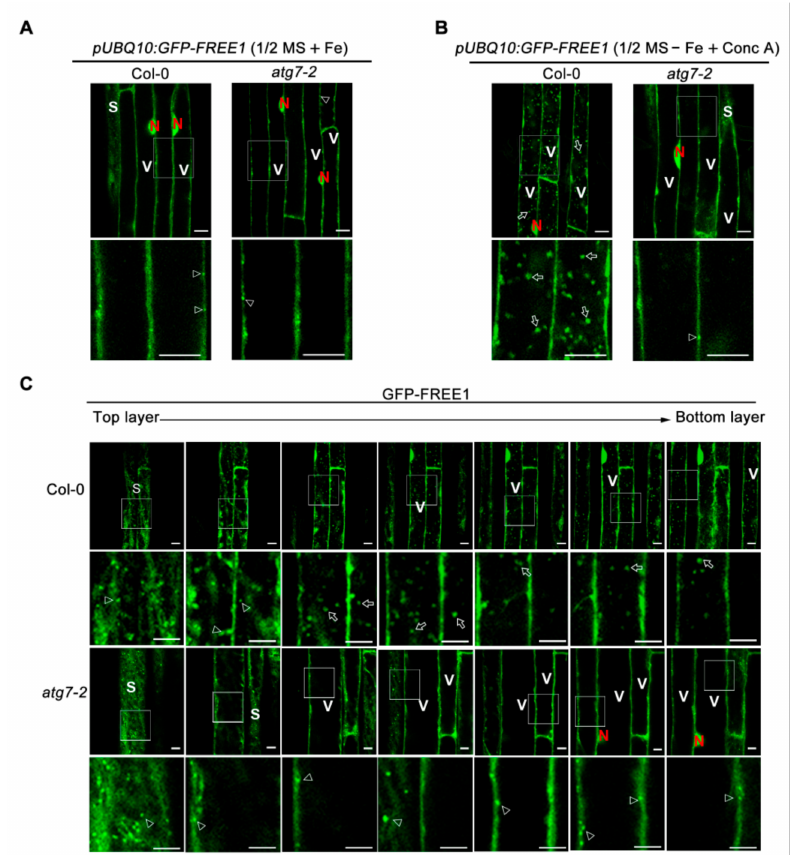
Figure 4. Autophagy-dependent FREE1 entry into the vacuole in response to iron-deficiency. ( A ) and ( B ) 6-d-old Arabidopsis seedlings expressing proUBQ10:GFP-FREE1 in Col-0 and atg7-2 background grown on 1/2 MS + Fe medium plates ( A ) were transferred to 1/2 MS-Fe liquid medium for 12 h followed by another 8 h treatment in 1/2 MS − Fe liquid medium containing 0.5 µ M Conc A before confocal observation of the root elongation zone. The untreated plants were used as a control. The punctate MVB localization of GFP-FREE1 was easily observed in the surface layer (the thin cytoplasm region) of the root cells in the elongated zone. The number of GFP-FREE1 puncta inside vacuole was obviously decreased in atg7-2 mutant comparing with that in WT plant cells. Bars = 10 µ m. ( C ) Serial confocal optical section of those plants shown in ( B ). S stands for surface layer of the indicated cell; V stands for vacuole; N stands for nucleus. The punctate MVB localization of GFP-FREE1 could be seen in the surface layer (the thin cytoplasm region) of the root cells and was indicated by arrow heads. The representative GFP-FREE1 puncta inside vacuole was indicated by arrows. Bars = 10 µ